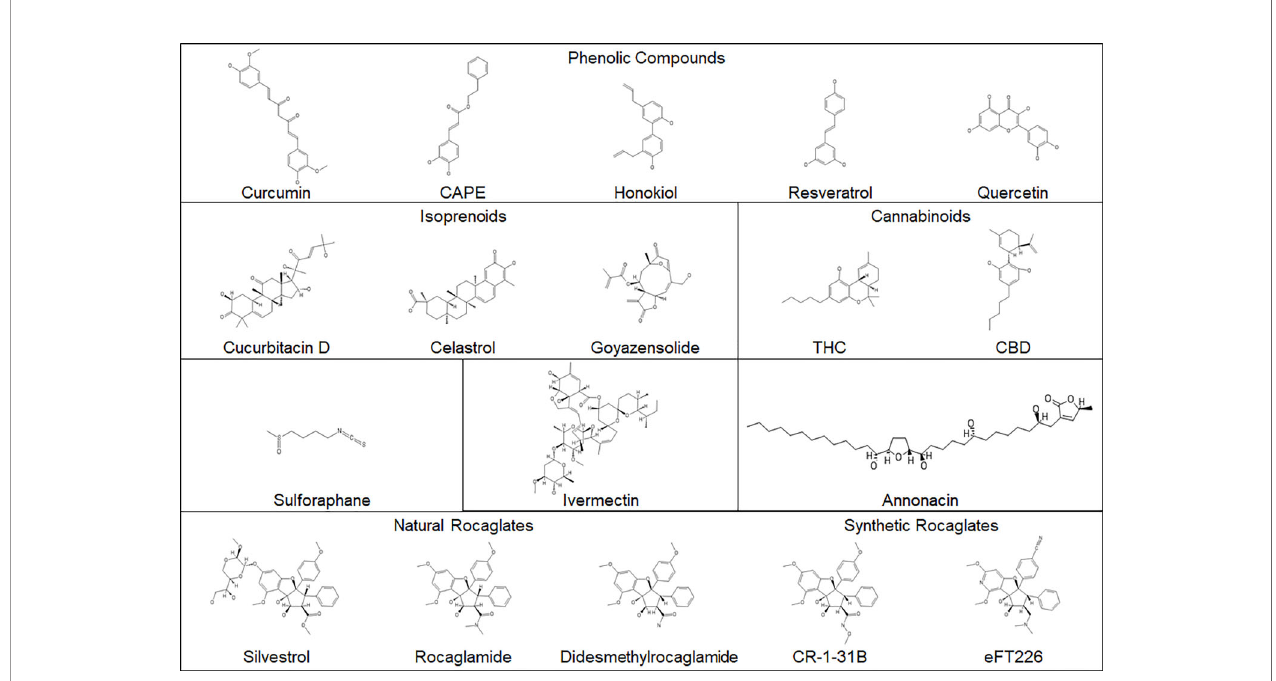
FIGURE 2 | The structures of the natural compounds evaluated in NF-associated disease. Synthetic rocaglates are included for